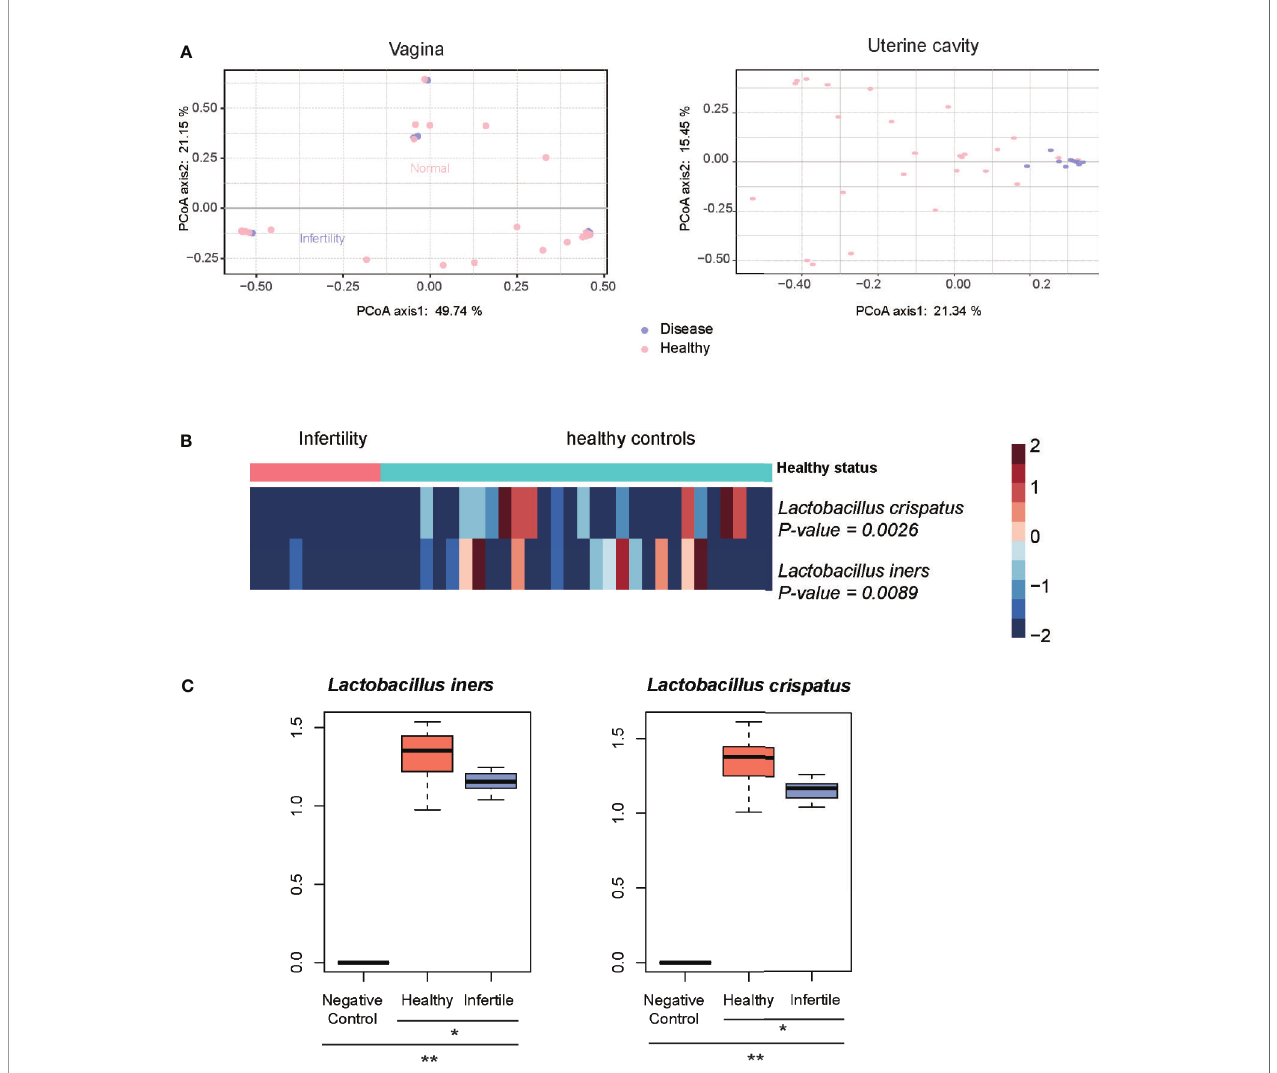
FIGURE 4 | Characteristics of microbiota in infertility of reproductive-aged women. (A) Principal coordinates analysis (PCoA) on the Bray – Curtis distance at the species level for all taxonomic pro fi les at the vagina and uterine. (B) Heatmap of relative abundance of species scaled from − 2 to 2 in the infertility and healthy controls communities. (C) The difference of abundances of two Lactobacillus species between the infertile patients, healthy controls, and negative controls by qPCR method. *P-value < 0.05, **P-value <